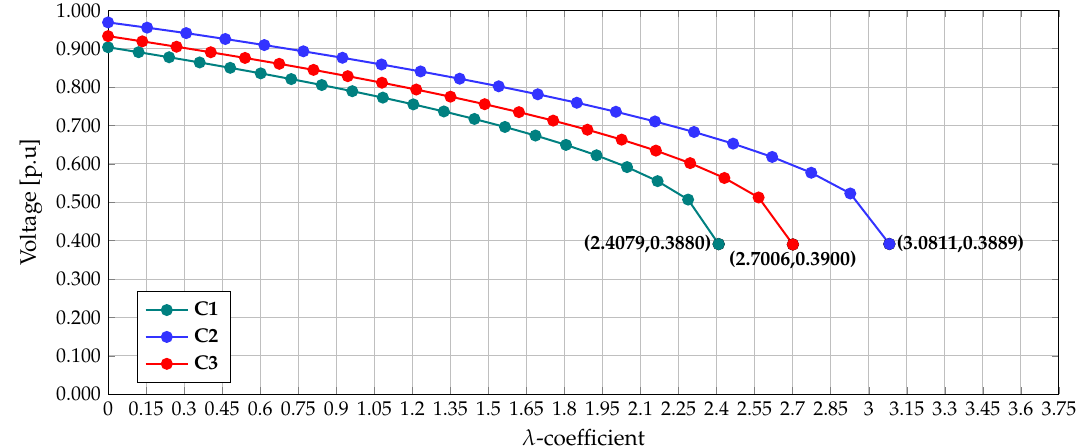
Figure 4. Stability curve λ − V for the most critical node in all the simulation